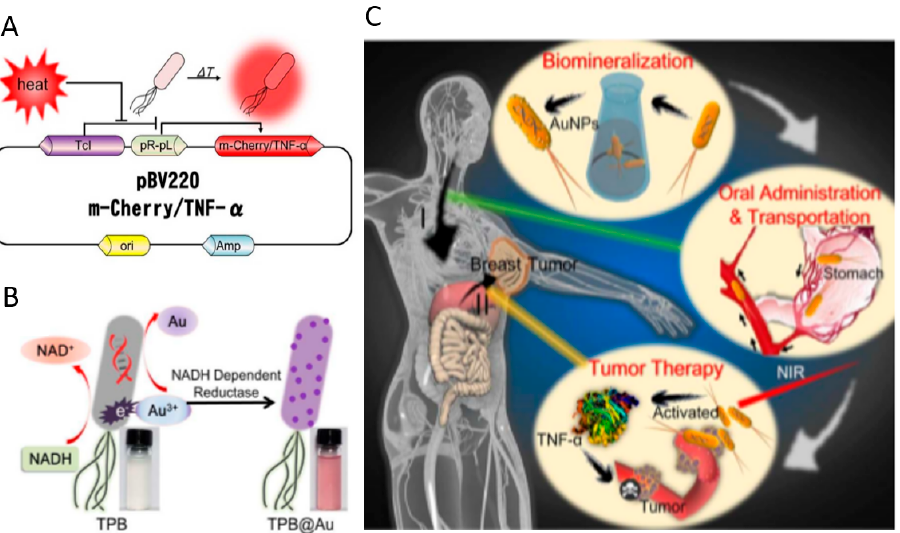
Figure 8. Oral delivery of bioengineered E. coli for cancer therapy. ( A ) Scheme of the mechanism of TNF- α expression in plasmid pBV220. ( B ) Preparation of thermally sensitive bacteria (TPB@Au). ( C ) Therapeutic effects and mechanism of the orally delivered TPB@Au. Adapted with permission from [111]; published by American Chemical Society,